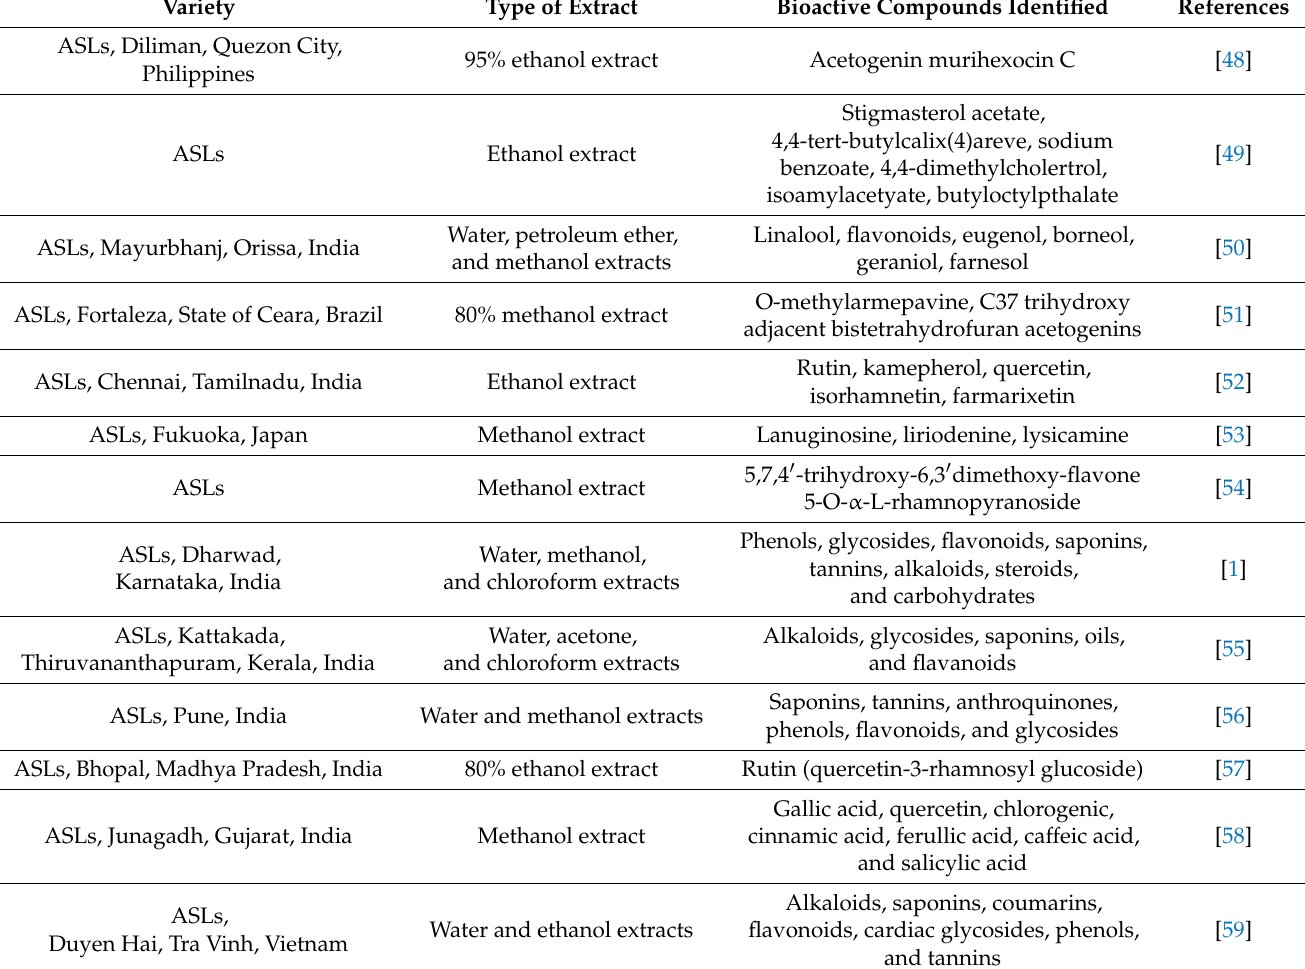
Table 3. Secondary metabolite profile of Annona squamosa L.